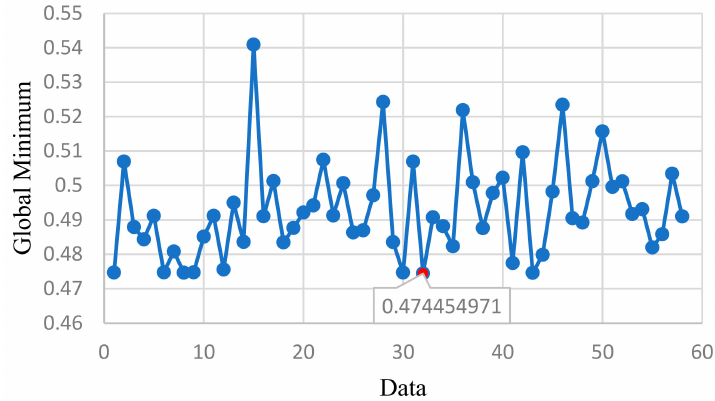
Figure 2. The optimization